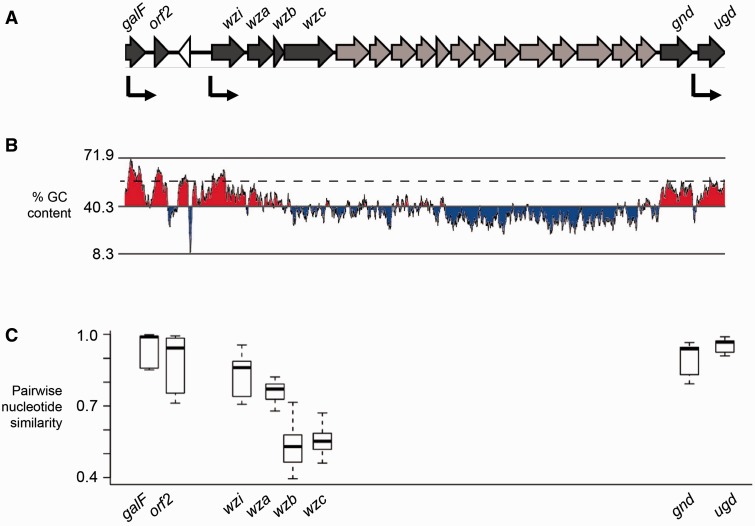
Macrostructure and features of Klebsiella pneumoniae cps loci. (A) Structure of a representative cps locus, cps-B (individual structures cps A–K are given in fig. 4). Filled arrows indicate size and direction of protein-coding genes; dark gray, conserved CDSs present in all cps loci (gene symbols labeled); light grey, nonconserved CDSs (present in cps-B but not other cps loci); white arrow, transposase. Black arrows indicate the relative start position and direction of transcriptional units as described in Shu et al. (2009). (B) G + C content across cps-B; red and blue indicate above and below the mean G + C content of the locus. Dashed line indicates mean G + C across the whole genome (57%). Note that although only cps-B is represented here, we observed a similar G + C content pattern across all cps loci. (C) Distributions of pairwise nucleotide similarities among CG258 cps loci, for conserved genes only.